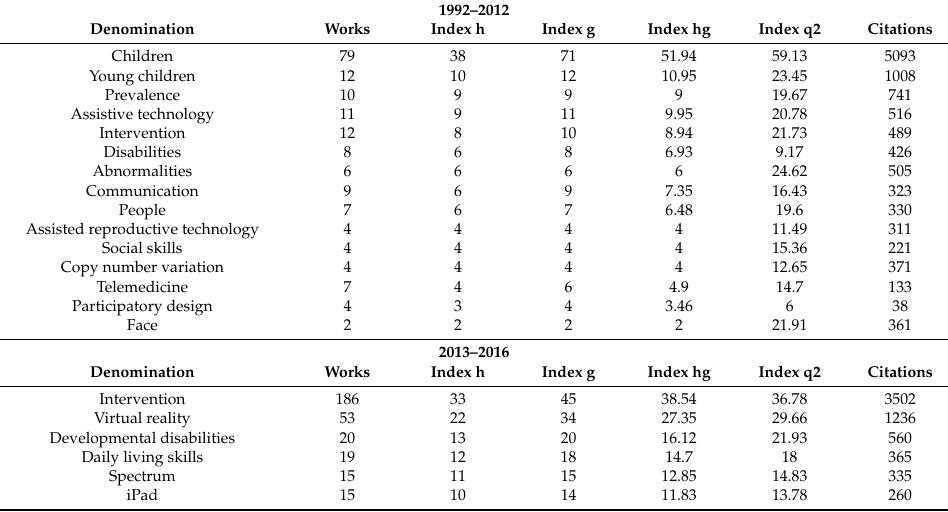
Table 10. Thematic research on